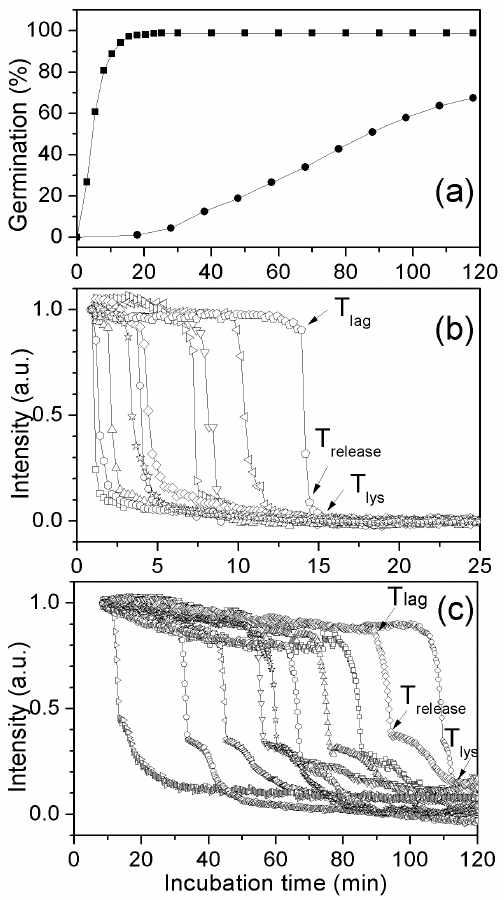
Figure 6. Germination of multiple individual G.stearothermo- philus spores with CaDPA. Unactivated spores were germinated with CaDPA at various temperatures, and germination of individual spores N was followed by DIC microscopy as described in Methods. Germination ), with germination of $ 380 individual spores at 65 u C ( & ) or 25 u C ( examined was shown in (a). Kinetics of germination of ten individual spores at 65 u C (b) or25 u C (c) was given in (b, c).